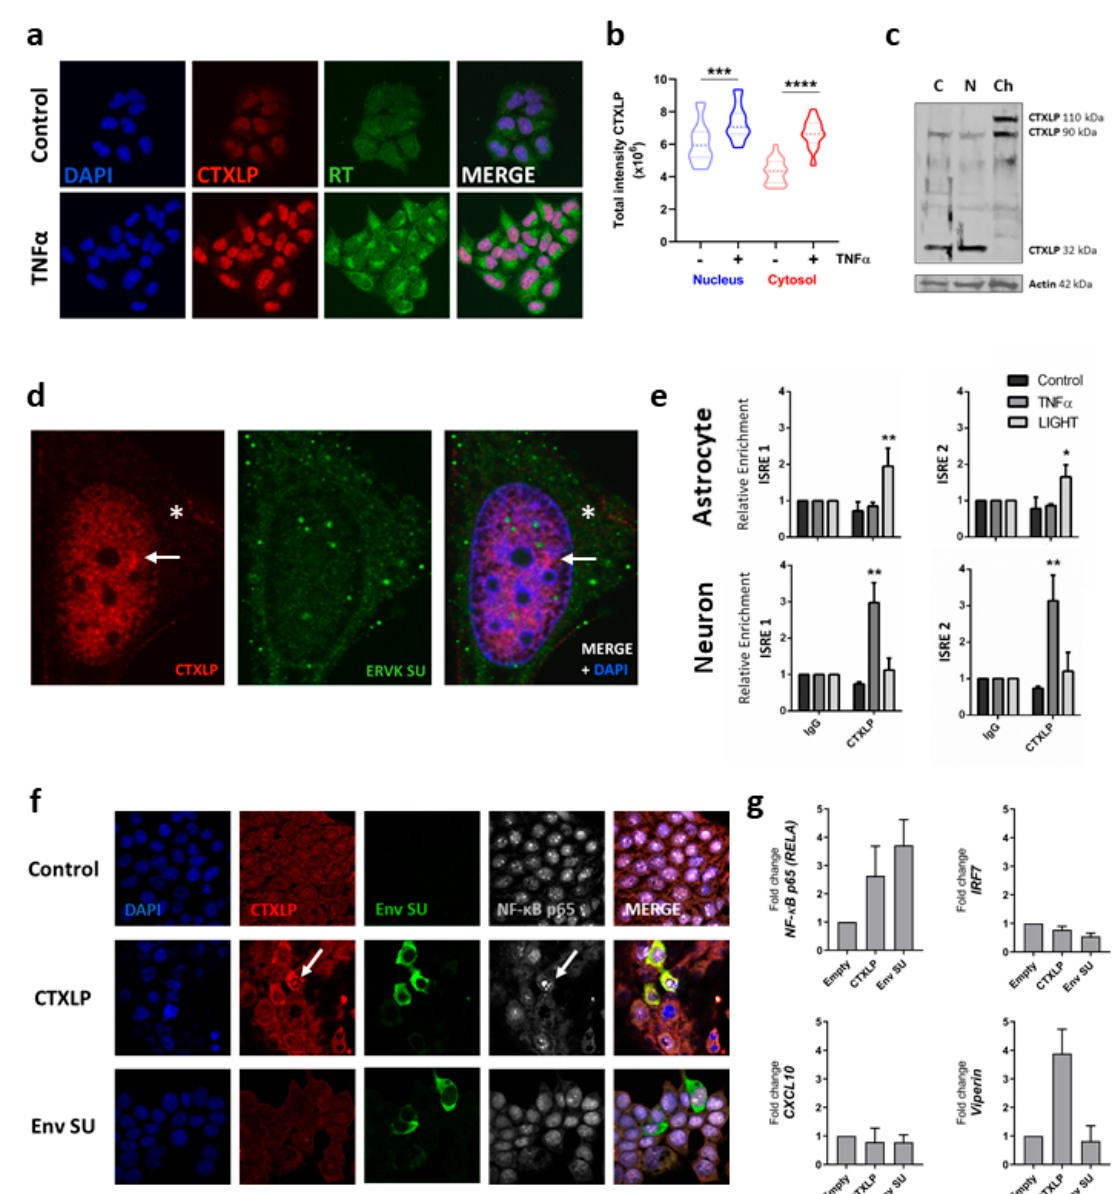
Figure 3. ERVK CTXLP is induced by inflammatory signals. ( a ) The pro-inflammatory cytokine Tumor Necrosis Factor-alpha (TNF α ) enhances ERVK CTXLP levels in human astrocytic SVGA cell line. Representative confocal micrographs depicting ERVK CTXLP (red) and ERVK reverse transcriptase (RT, green) in cells treated with or without 0.1 ng / mL TNF α for 24 h, n = 2. DAPI stain indicates nuclei (blue). CTXLP mainly localized to the nucleus with di ff use cytoplasmic staining. ( b ) Quantification of CTXLP staining in untreated and TNF α -treated SVGA cells highlights the increase in both nuclear and cytoplasmic expression of CTXLP under inflammatory conditions (*** p < 0.001, **** p < 0.0001). ( c ) Cell fractionation further supported the nuclear localization of CTXLP proteins in SVGA cells. Cytoplasmic (C) and nuclear fractions (N) expressed mainly the small form of CTXLP (32 kDa), whereas larger (90–110 kDa) isoforms of CTXLP were mostly confined within the cellular chromatin (CHR) fraction ( n = 4). ( d ) Upon TNF α treatment, although the expression of CTXLP and Env SU proteins was enhanced in SVGAs, they did not co-localize upon merging confocal microscopy images. CTXLP nuclear foci are indicated by an arrow, whereas cytoplasmic puncta are indicated by an asterisk. Together, this reveals that CTXLP expression exhibits a distinct cellular distribution pattern from